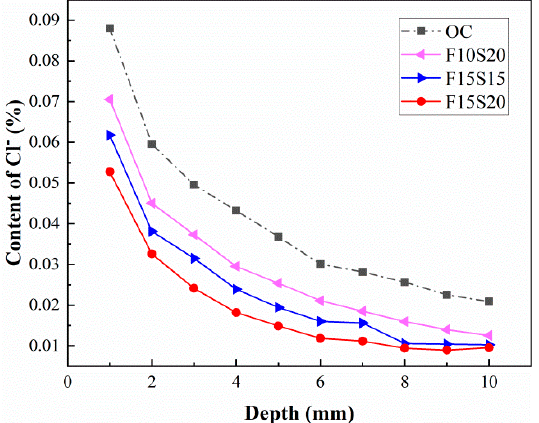
Figure 15. Variation curve of Cl − content with depth in concrete on the 28th day.